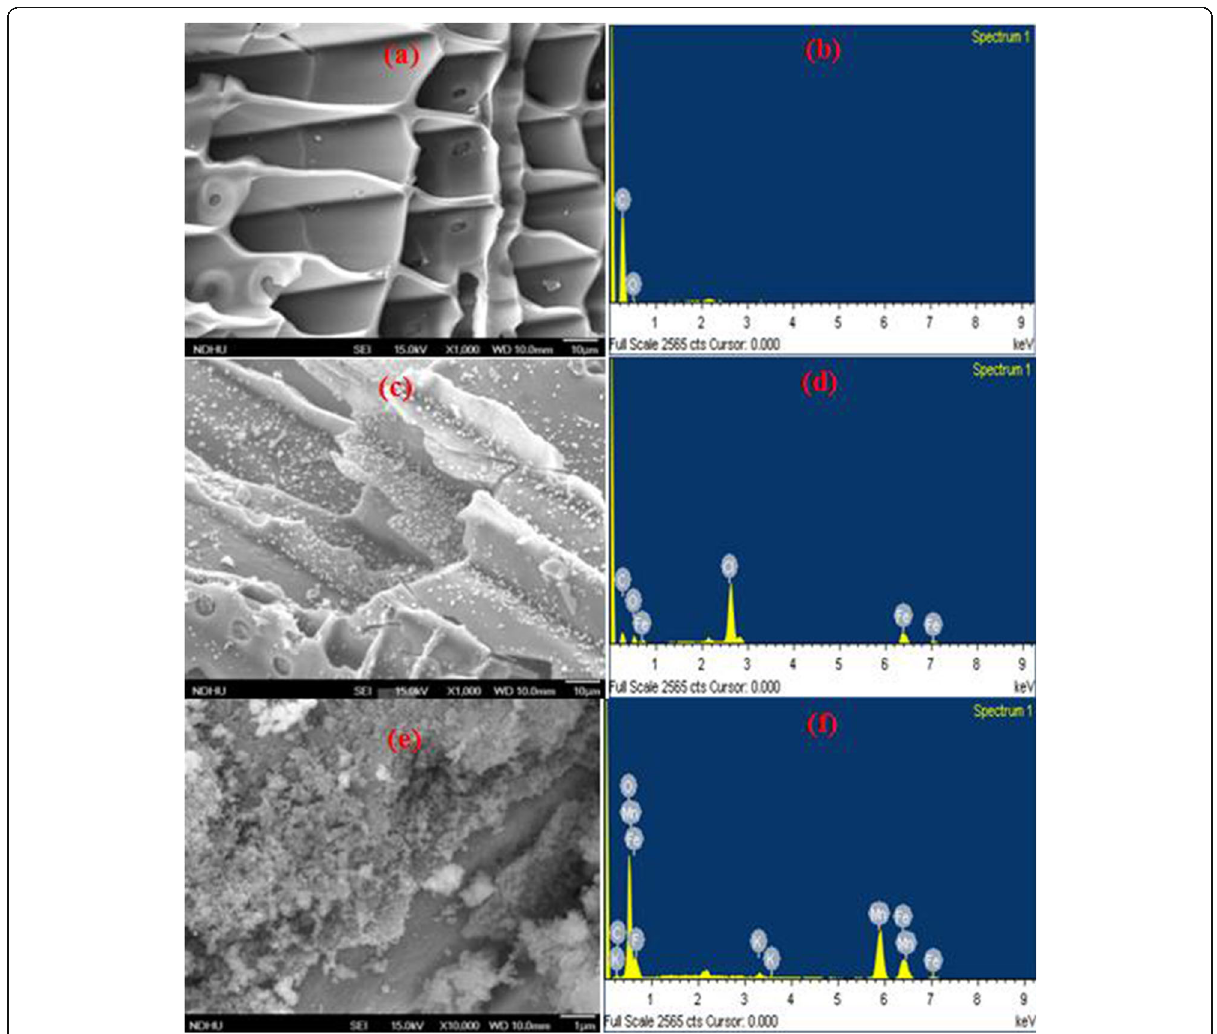
Fig. 2 SEM images and EDS analysis of a , b PB, c , d 1FeC and e , f